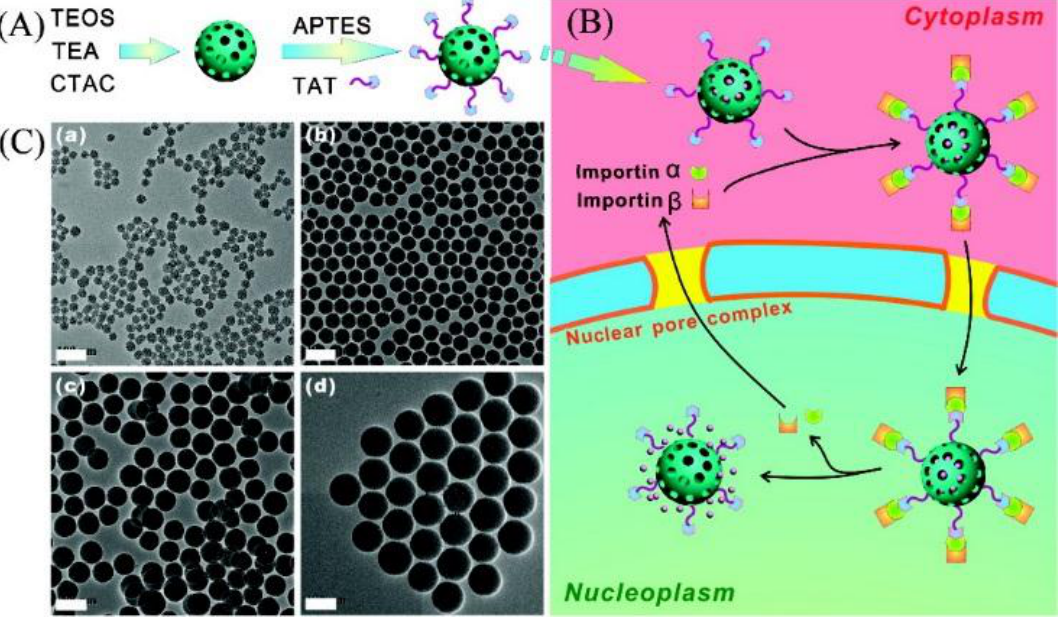
Figure 2. ( A ) Procedures for preparation amine group- and TAT peptide-conjugated mesoporous silica nanoparticles (MSNs); ( B ) an illustration of doxorubicin (Dox)@MSNs-TAT for targeting nuclei of cancer cells and delivering/releasing drugs directly into nuclei; ( C ) Transmission electron microscope transmission electron microscope (TEM) images of MSNs with different sizes. Scale bars: 100 nm. Reproduced with permission from [55]. Copyright 2012 American Chemical Society.